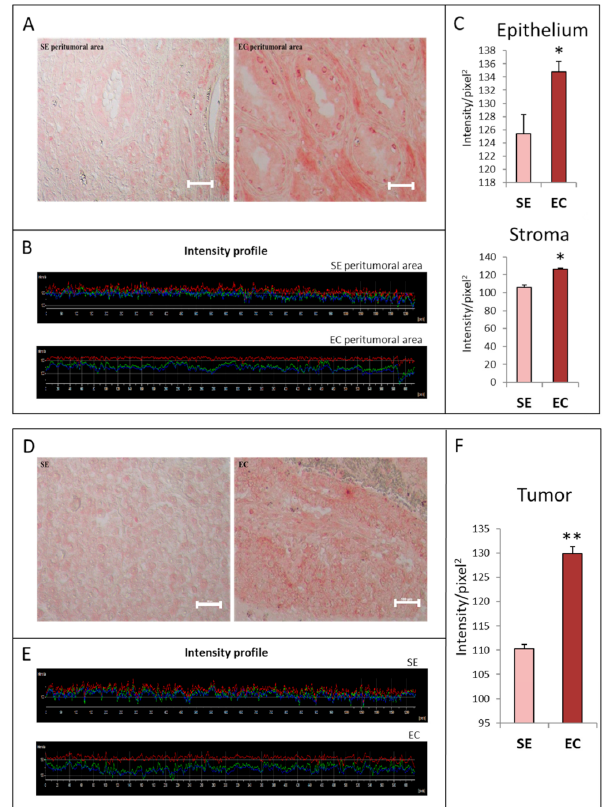
Figure 1. Representative images of HGF immunoreactivity ( A , D ) in seminoma (SE) and embryonal carcinoma (EC) samples ( D ), and their peritumoral areas ( A ). Representative intensity profiles of immunohistochemical experiments are shown in panel ( B ) (peritumoral areas) and ( E ) tumoral lesions. ( C ) Graphical representation of the quantification of HGF immunostaining in epithelial and stromal parts of SE and EC peritumoral areas. ( F ) Graphical representation of the quantification of HGF immunostaining in SE and EC samples. Four di ff erent SE histological samples and two EC histological samples were examined. Bar: 100 µ m. * p < 0.005; ** p <